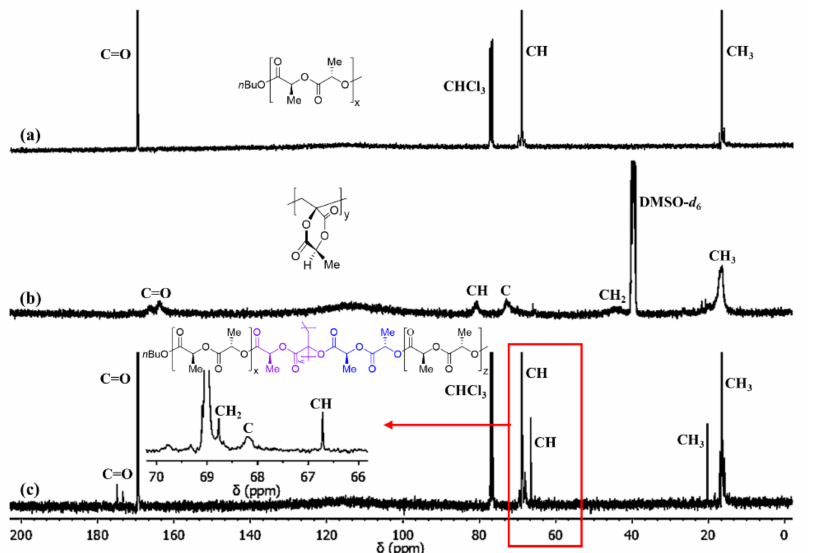
Figure 5. 13 C-NMR spectra of homopolymers and graft copolymers: ( a ) PLA (100 MHz, CHCl 3 - d 1 ); ( b ) PMLA (100 MHz, DMSO- d 6 ); and ( c ) P(MLA- g -LLA) (100 MHz, CHCl 3 - d 1 ). FT-IR spectra of PMLA with different amounts of AIBN (5, 10, 15, 20, and 25 mol%) are shown in Figure 1. The spectrum of PMLA shows vibrational peaks of C=O and C–O stretching at around 1747 and 1110 cm − 1 , while the stretching and bending vibrations of C–H are seen at around 2949–2950 and 1447 cm − 1 . The PLA shows vibrational bands due to C–O stretching around 1085 cm − 1 , C=O stretching at 1754 cm − 1 and C–H bending and stretching at 1455 and 2997 cm − 1 , respectively. Figure 3 shows the FT-IR spectra of PMLA, PLA and P(MLA20- g -LLA) with various PMLA:LLA composition ratios respectively. In comparison, the P(MLA- g -LLA) spectrum shows the characteristic peaks of C–O